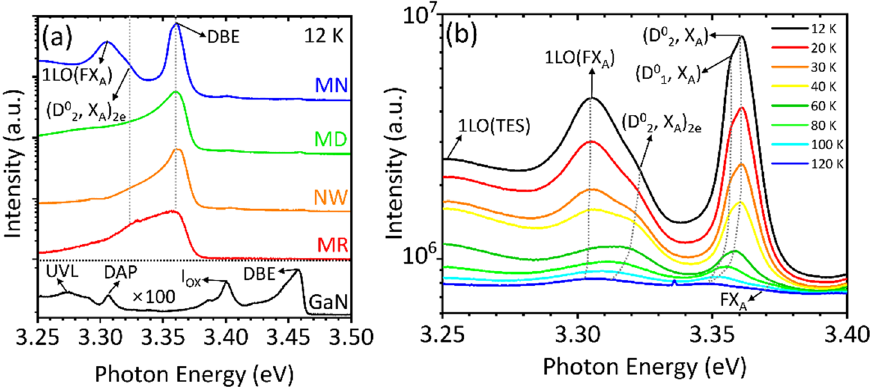
Figure 6. Optical properties of remote epitaxial ZnO crystals/SLG/GaN. ( a ) Low-temperature PL spectra of remote epitaxial ZnO crystals. ( b ) Temperature-dependent PL spectra of MN. a.u. denotes arbitrary